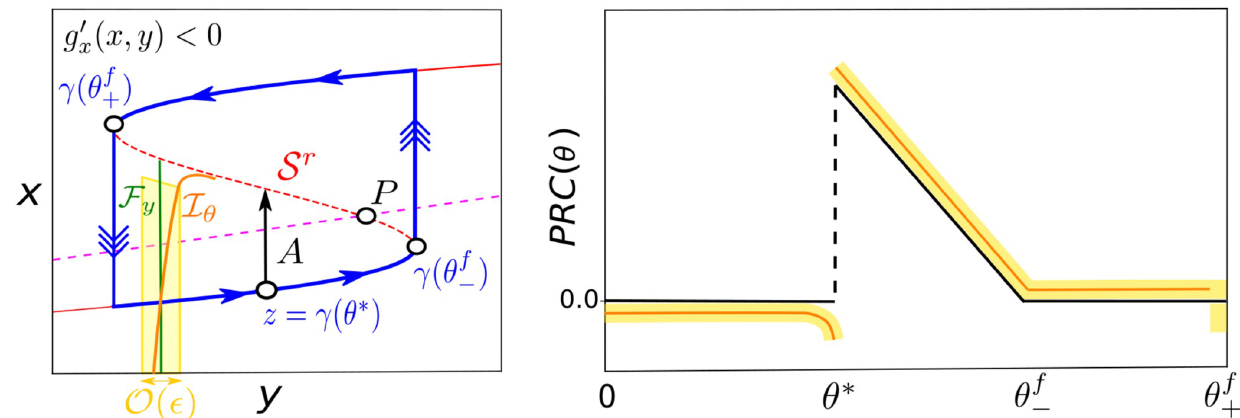
Fig 6. PRC of pulses A > 0 for relaxation oscillators. Next we sketch the PRCs for pulses of amplitude A > 0 for the case g 0 ð x ; y Þ < 0 . For phases θ < θ � , x where θ � satisfies g ð y � Þ þ A 2 S r , due to the slope of isochrons the effect of the pulses will be to delay trajectories. Since isochrons approach the unstable point P through S r , the closer the phase θ to θ � , the larger the bending of the isochrons and thus the larger the corresponding delay value. For phases y � < y < y f , there is an advancement proportional to the fraction of cycle skipped. This prevalence of advancements is also seen for points in the upper (cid:0) branch. For phases in a neighbourhood of the fold point y f , we expect a transition between advancement and delays not drawn because our analysis is only (cid:0) valid for normally hyperbolic